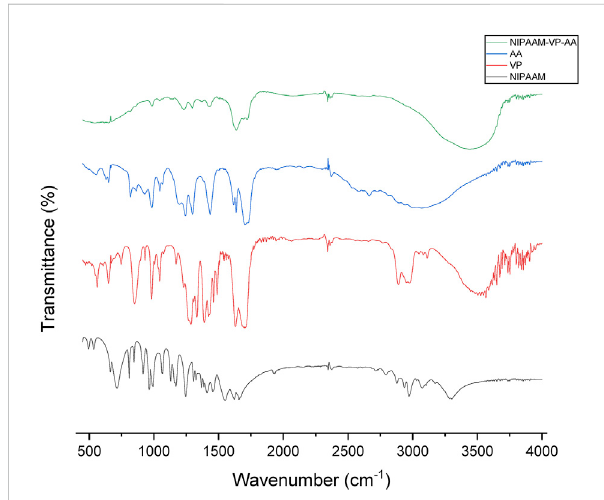
FIGURE 2 FT-IR spectra of N-isopropyl acrylamide (black), N-vinyl